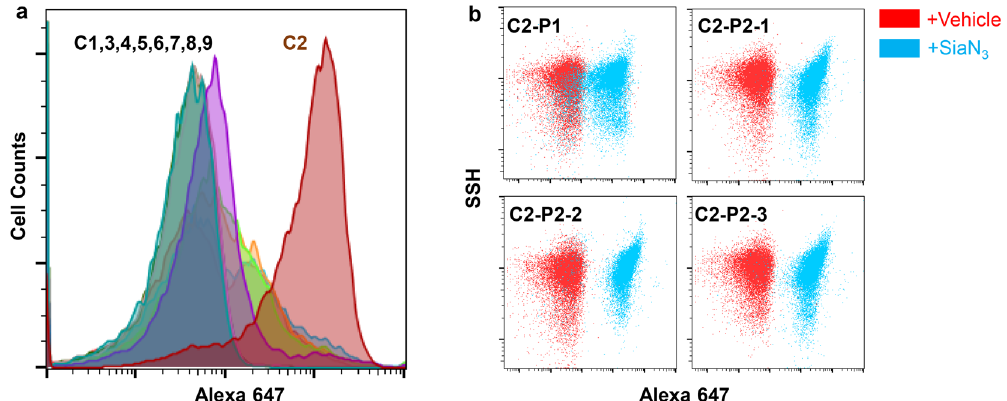
Figure 5. Isolation and passaging of the Sia9N 3 incorporating bacterial strain from H2 microbiome. ( a ) Colony screening of H2 microbiome isolated one Sia9N 3 incorporating bacterial strain. The raw H2 microbiota was diluted and plated on a Gifu-agar plate for overnight anaerobic culture, 10 colonies with different sizes and shapes were picked and cultured with the Gifu media supplemented with 200 μM Sia9N 3 and subjected to fluorescence labeling study aforementioned. ( b ) The Sia9N 3 incorporating feature is readily passaged to daughter generations. The cultured C2 media (C2-P1) was plated again and three colonies (C2-Passage 2, C2-P2-1,2,3) were picked for metabolic labeling study. Bacteria cultured from three colonies were almost 100% Sia9N 3 incorporating cells, indicating that a single Sia9N 3 incorporating bacterial strain is purified out from the microbiome